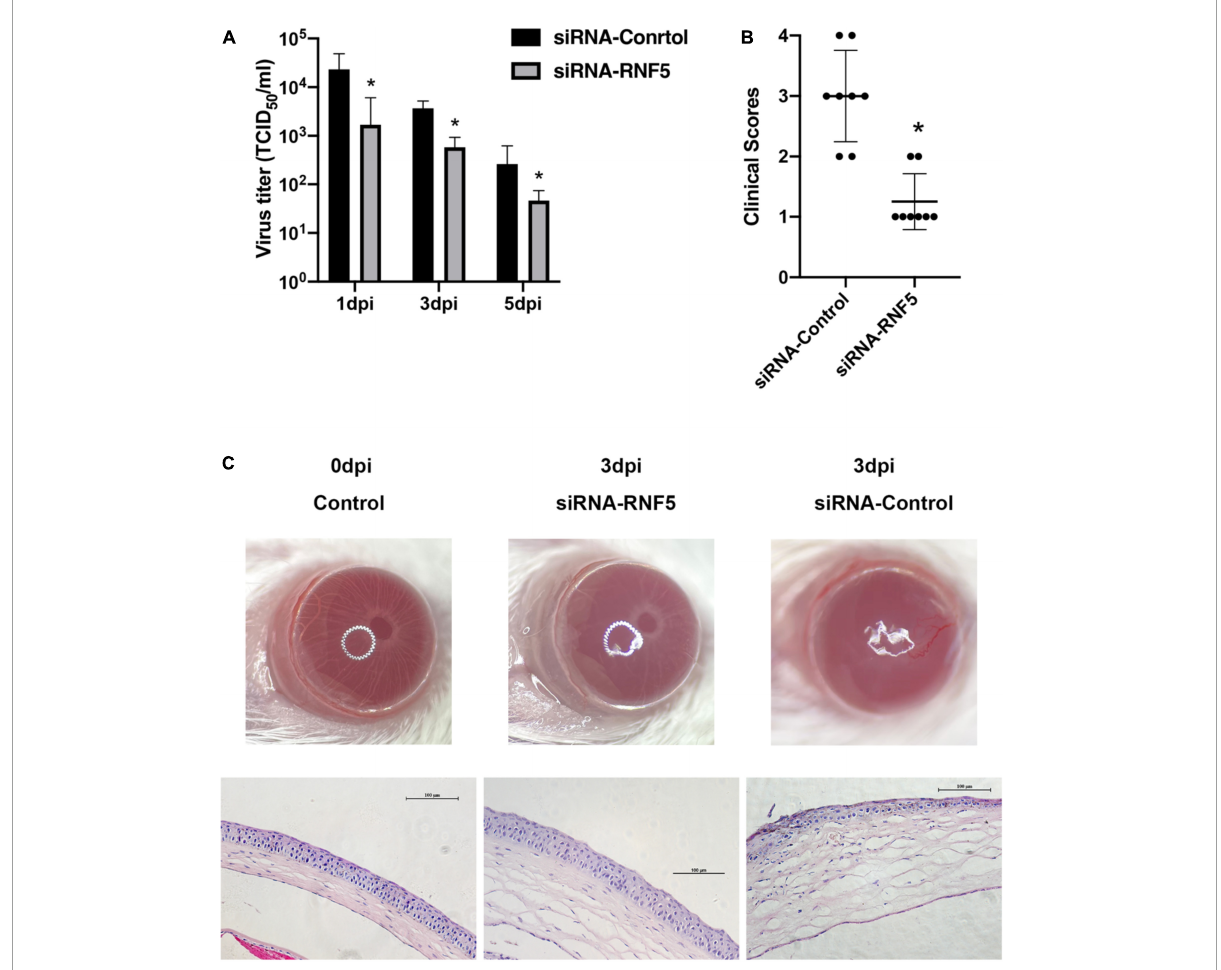
FIGURE5 Silencing RNF5 alleviates HSK severity in mice. (A) Effects of RNF5 silencing on viral titers in tears at 1, 3, and 5 days after HSV-1 infection in mice. (B) Clinical scores of mice infected with HSV-1 on day 3 after RNF5 silencing (8 mice/group). (C) Photographs showing the corneal